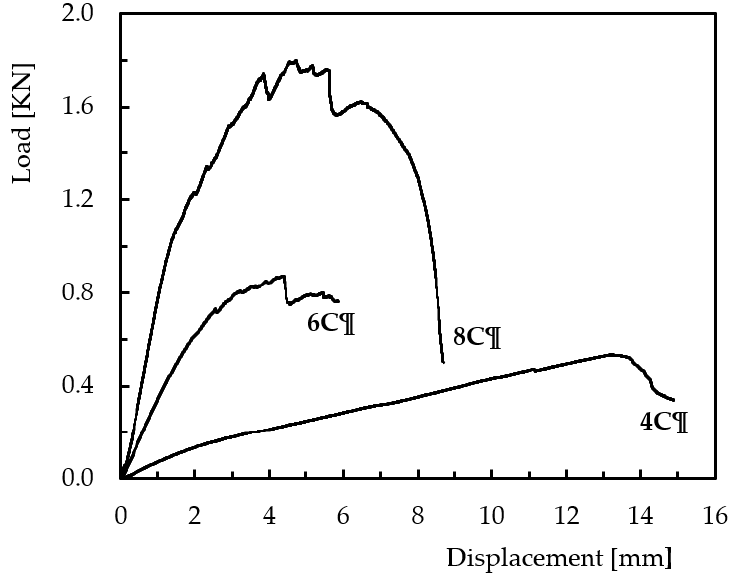
Figure 3. Effect of thickness on the compressive curves.